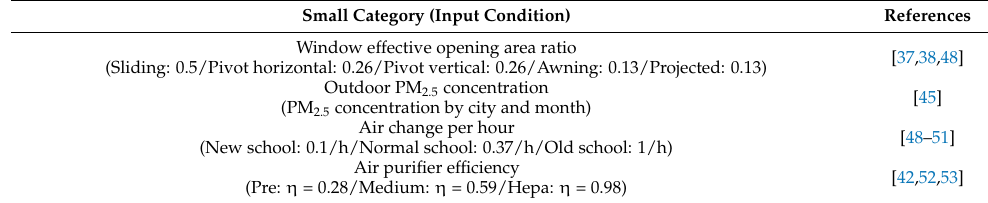
Table 4. Input conditions for PM 2.5 influencing